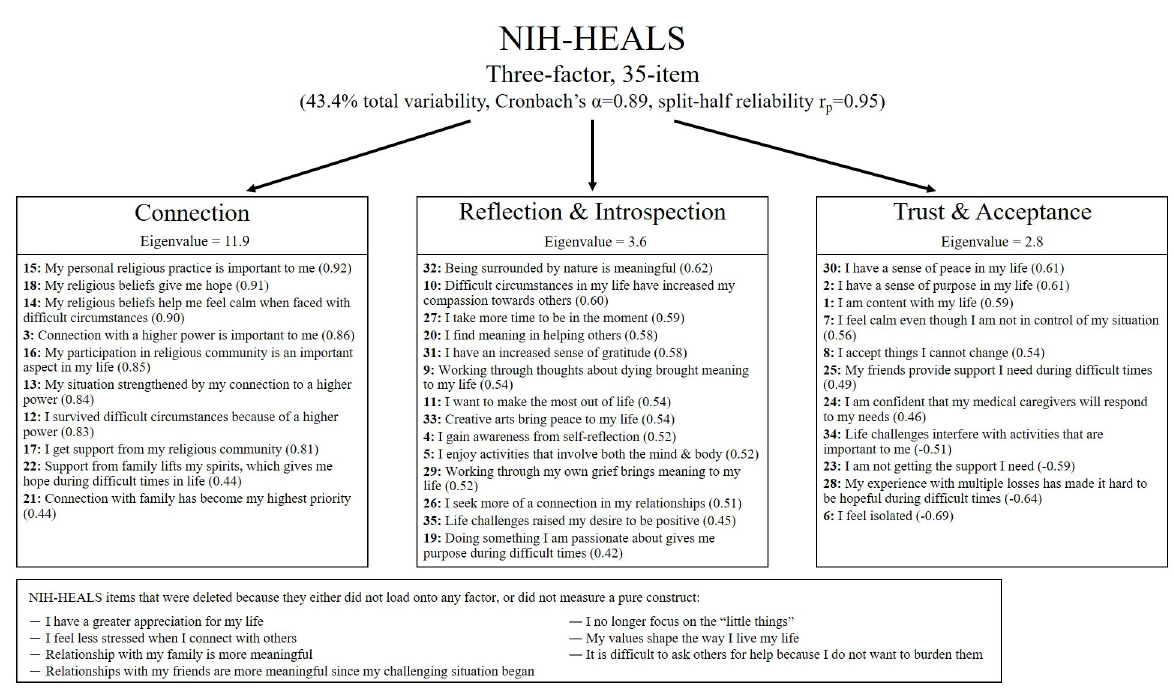
Fig 1. Three factor, 35-item NIH-HEALS measure. The three factors accounted for 43.4% of the total variability with excellent reliability (Cronbach’s alpha = 0.89, split-half reliability = 0.95). Retained items for each factor are listed along with their individual loadings (in parenthesis) from the exploratory factor analysis. Items 6, 23, 28, and 34 are reversed